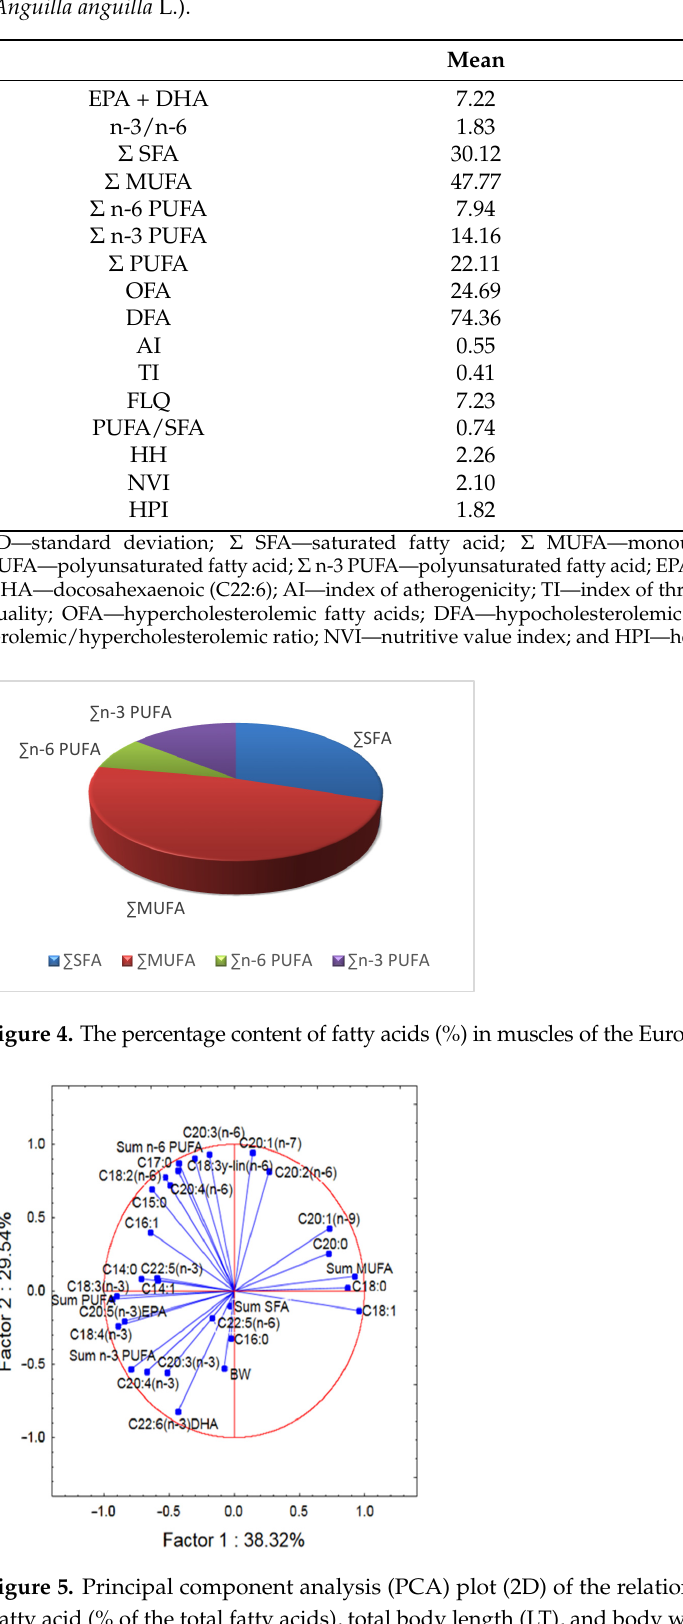
Table 4. Fatty acids composition (%) and indices of human health in muscles of the European eel ( Anguilla anguilla L.).